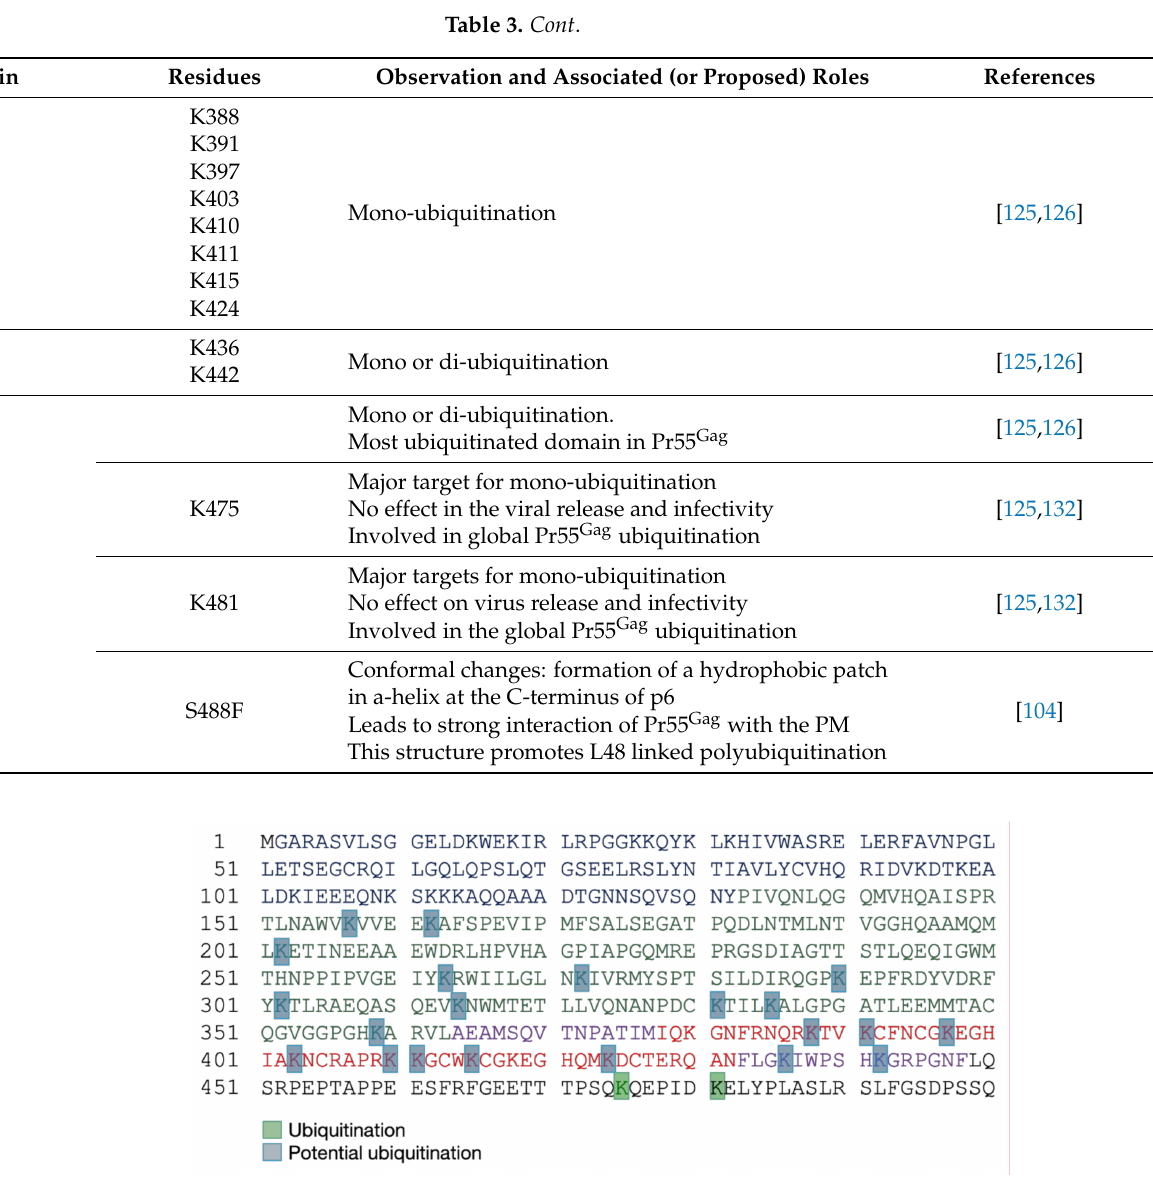
Figure 5. Ubiquitinylated residues in HIV-1 Pr55 Gag . The domains of Pr55 Gag are represented by different colors (see Figure 4). Experimentally identified ubiquitinylated positions are highlighted in light green. Potential ubiquitinylated positions are highlighted in light